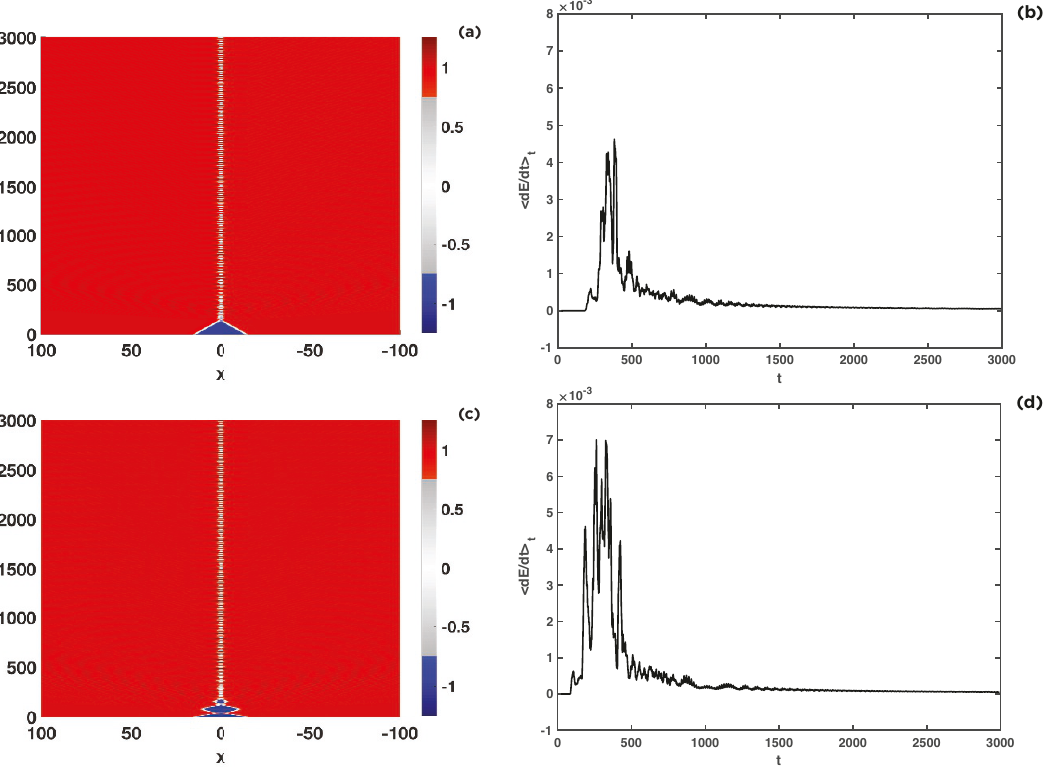
Figure 7 . (Left) (cid:30) ( x; t ) showing long-lived oscillations after the scattering. (Right) Corresponding time-averaged energy-emission rate < dE=dt > t . The parameters chosed are (cid:15) = 0 (upper (cid:12)gures) and (cid:15) = 10 (cid:0) 2 (lower (cid:12)gures). In both cases we (cid:12)xed v = 0 :